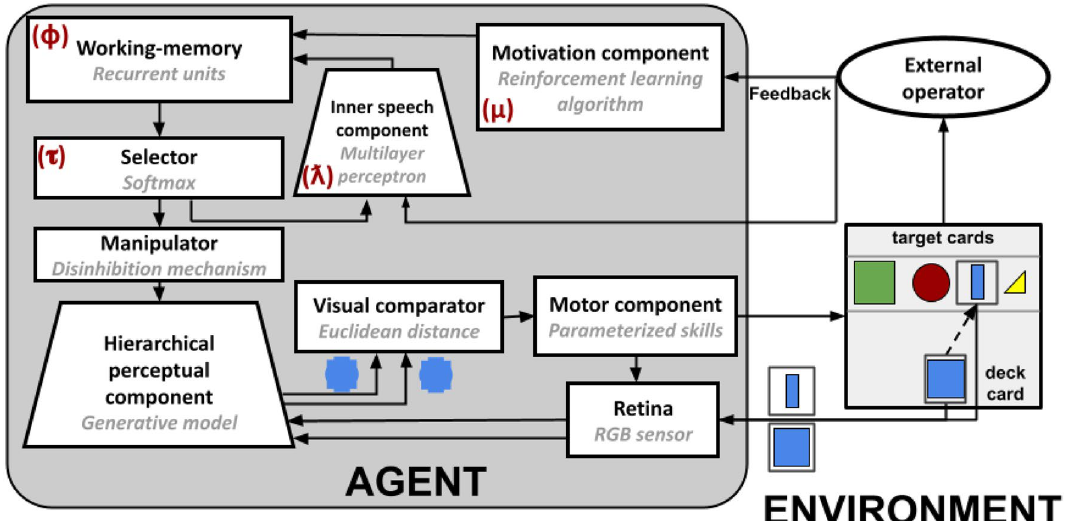
Figure 1. Architecture of the model. In each box, the component label is highlighted in bold, and the computational algorithm implemented by the component is highlighted in italic grey. The Greek symbols in red indicate the four key parameters of the model. The two little blue images under the visual comparator highlight that the visual comparison is based on the low-level representations of the deck and selected target cards. These visual representations are produced by the hierarchical component, through its generative capabilities, on the basis of the selected-rule top-down bias (here